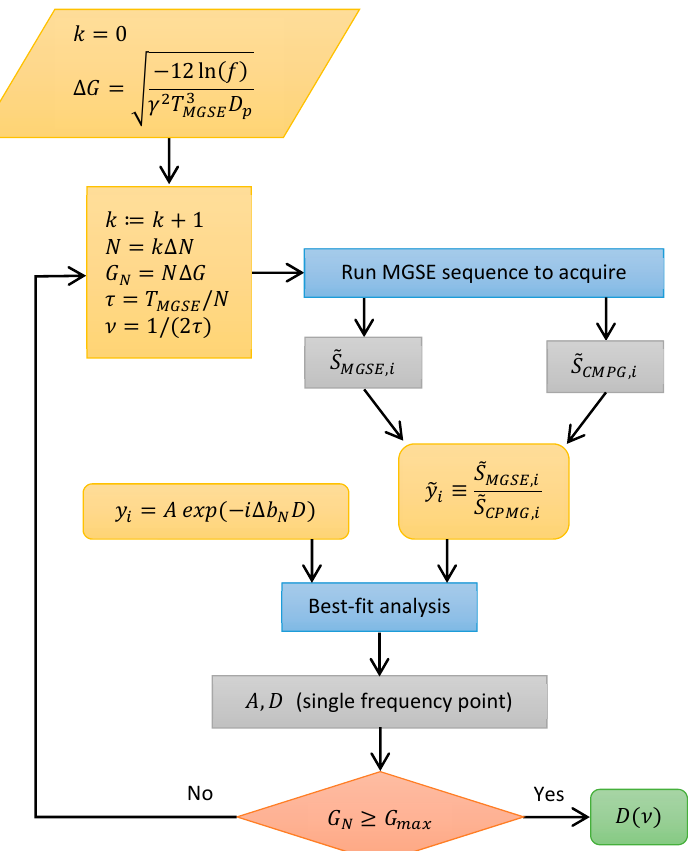
Figure 6. Flowchart diagram of the di ff usion spectra measurement procedure. The initialization of parameters is followed by a loop in which MGSE frequency, ν , is increased proportionally to the index, k . In each step, the gradient amplitude and inter-echo time are adjusted according to the MGSE frequency. The MGSE sequence and the corresponding CPMG sequence are initialized to acquire echo trains. From these measurements, the normalized echoes are calculated first and subsequently used to extract the parameters A and D using the best-fit model analysis. The loop ends with the di ff usion spectrum D ( ν ) measured when the required gradient exceeds the maximum gradient of the NMR system.